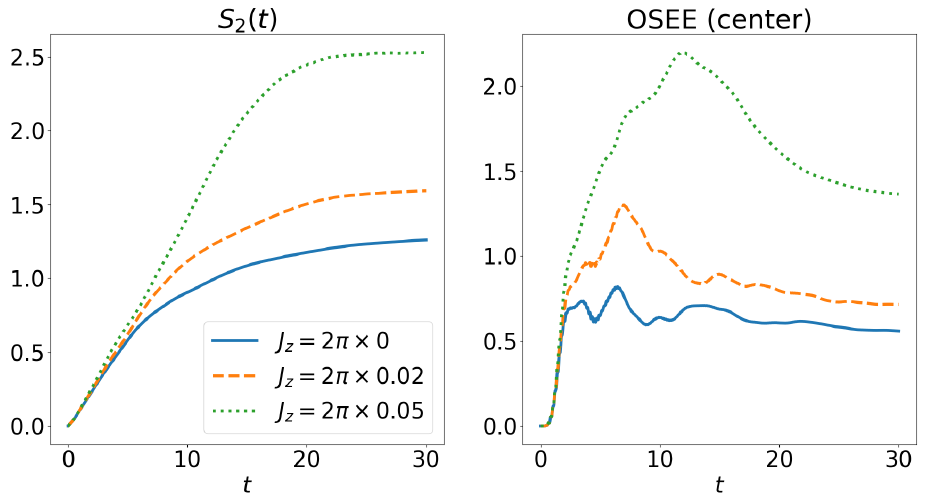
Figure 15: The second Rényi entropy S (left), and the operator-space entanglement 2 entropy for a bipartition of the system in its center (right), vs. the time t . The simu- lations are identical to those in Fig. 14 ( N = 22 plaquette topology), showing a clear increase in the complexity of the dynamics with increasing J z